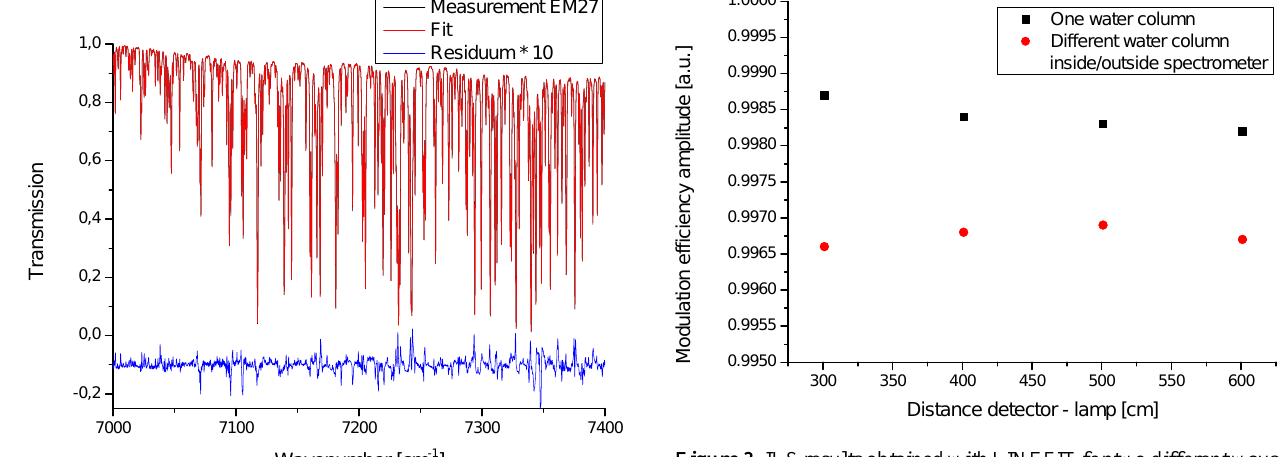
Figure 3. ILS results obtained with LINEFIT for two different ways of performing the analysis. The simple analysis assumes a uniform Figure 2. Transmission spectrum of 4m lab air (black curve) in the path between lamp and detector, whereas the more refined approach 7000–7400cm − 1 region. Overlying is the LINEFIT calculation (red divides the observed absorption into one contribution from inside curve), the residuum multiplied by a factor of 10 is shown in blue. and one from outside the spectrometer. Results are in agreement For clarity reasons, an offset of − 0.1 was added to the residuum. within Table 1. Compilation of ILS modulation efficiencies measured at maximum OPD = 1.8cm. Measurements were performed in Karl- sruhe in June and July 2014, in between the spectrometers were transported for campaign measurements by road thus experiencing a lot of mechanical impacts and vibrations. Instr. 3 Jun